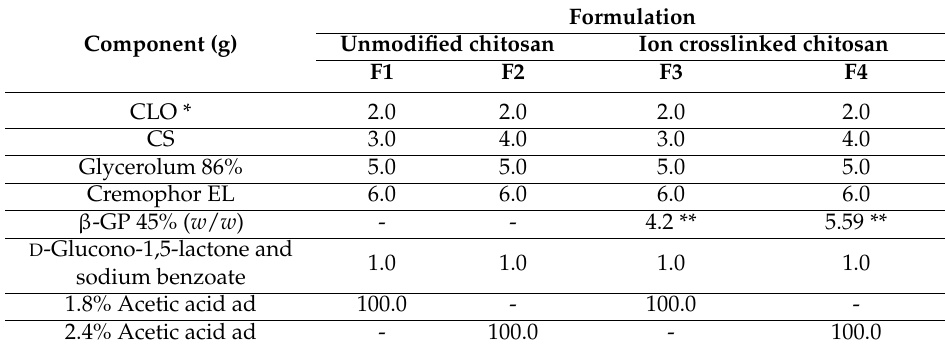
Table 1. Composition of hydrogels with unmodified or β -GP crosslinked chitosan (CS).